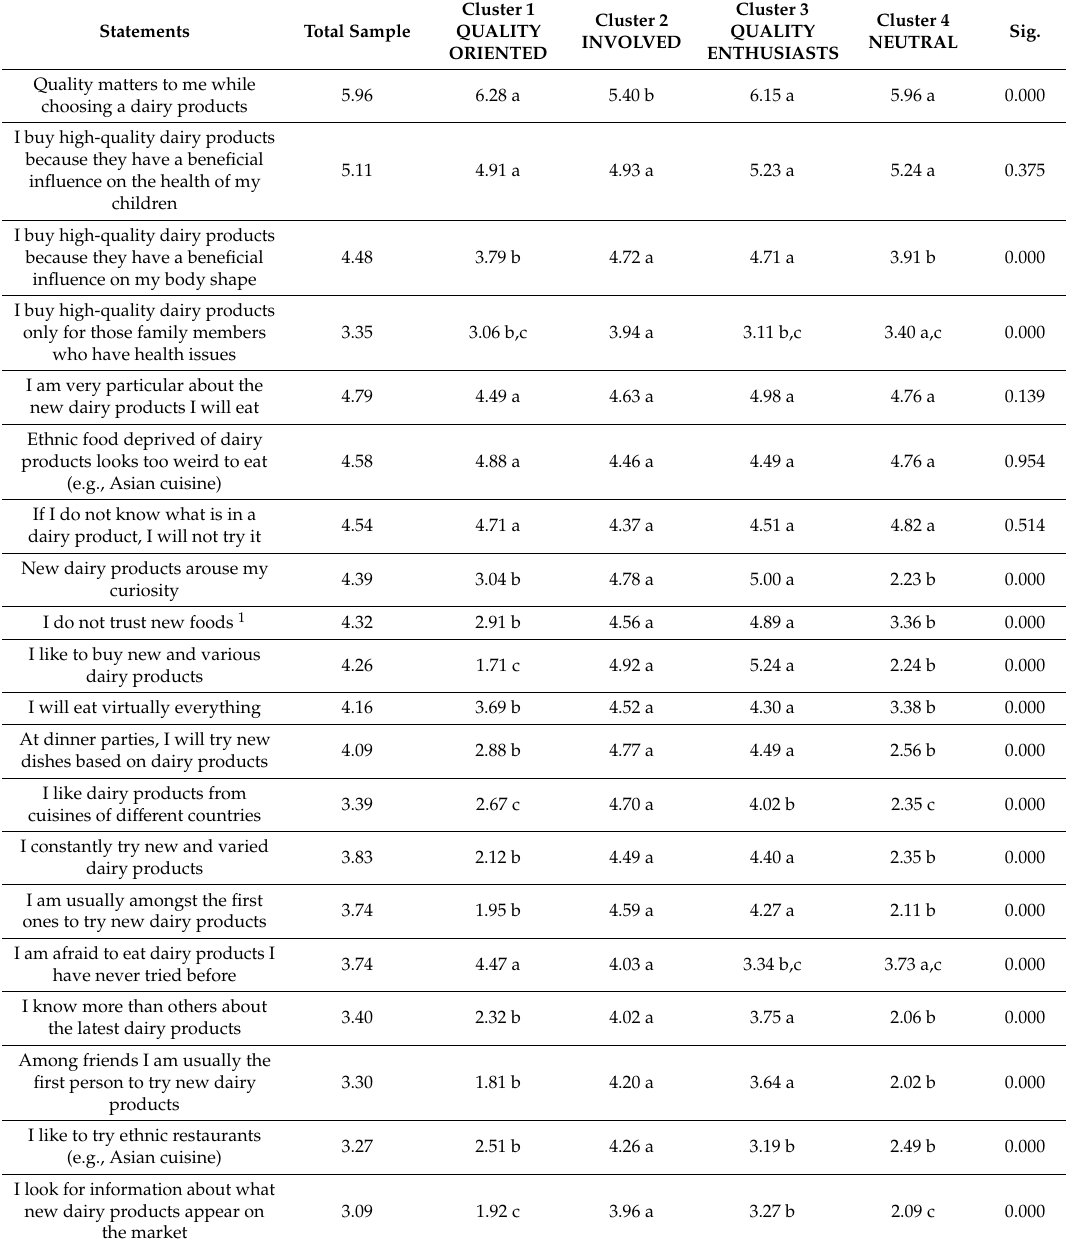
Table 4. Clusters’ profile on attitudinal questionnaire referring to the importance of dairy products quality and openness to buy new products as well as changes in the market including dairy products ( N =